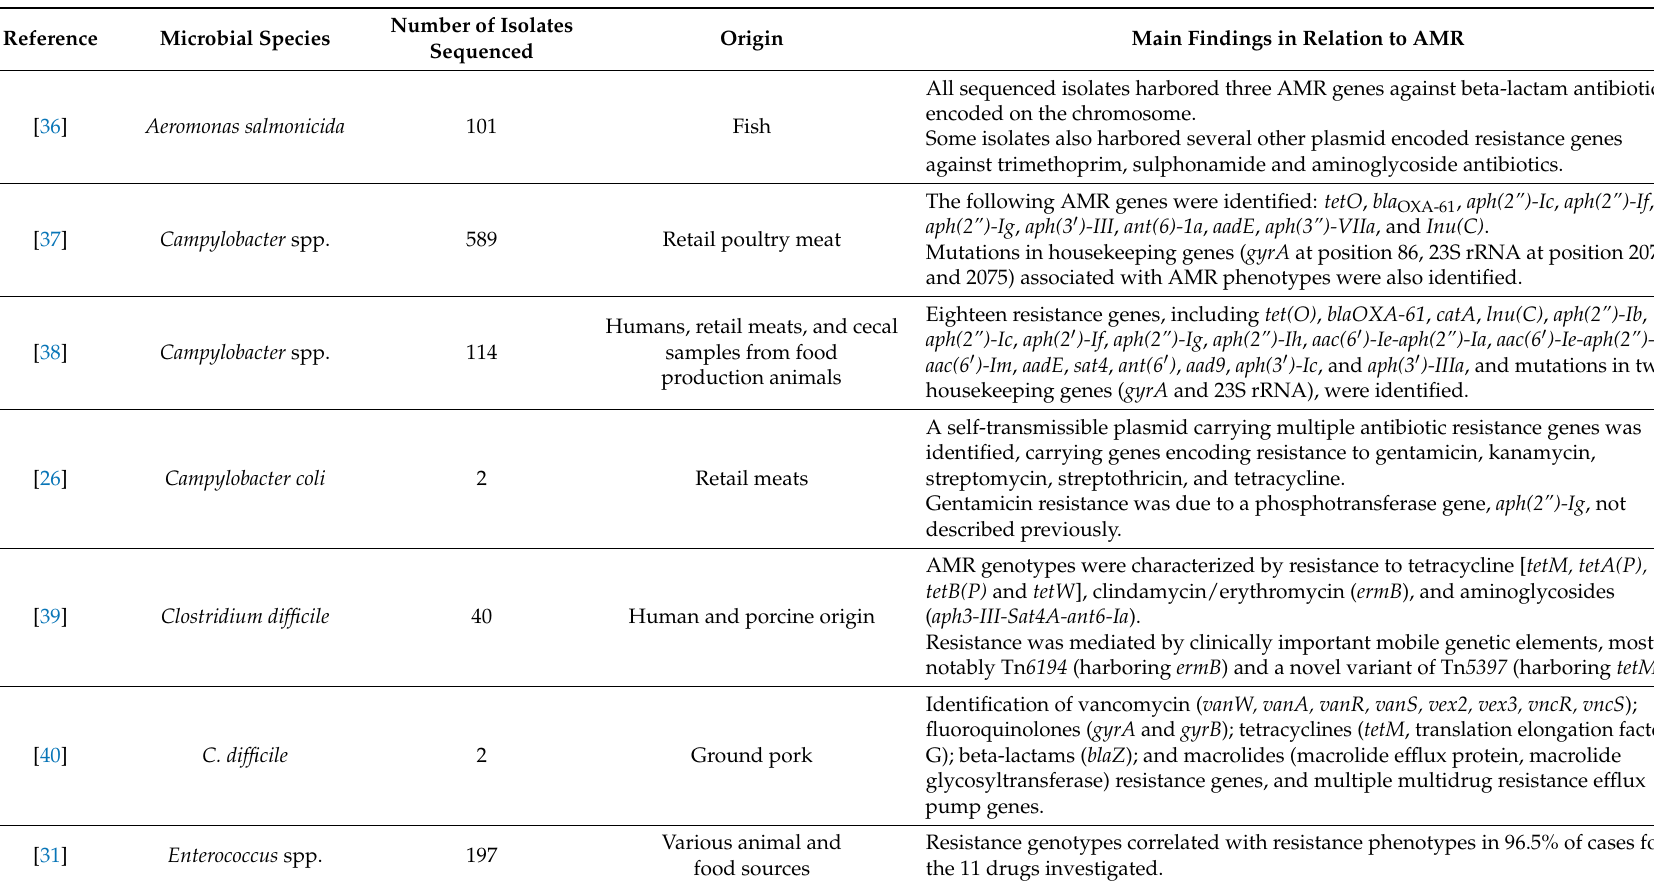
Table 1. Main research studies published in recent years applying whole genome sequencing (WGS) to characterize antimicrobial resistance (AMR) in foodborne